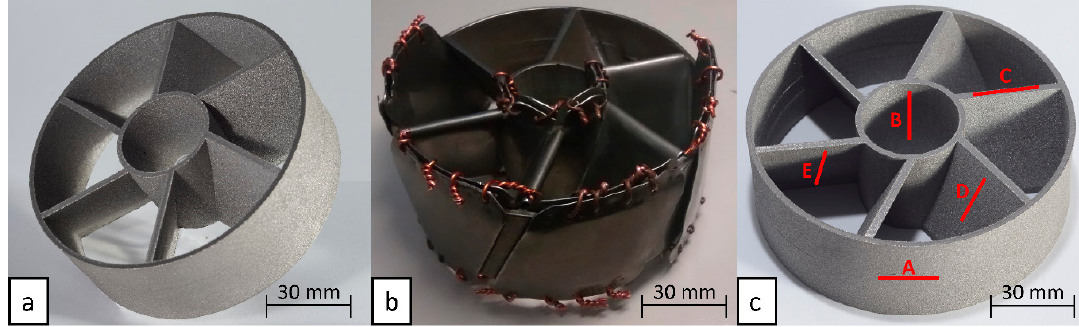
Figure 12. Selective laser melting (SLM) Ti6Al4V impeller ( a ), shielded blades ( b ), and measured zones ( c ).